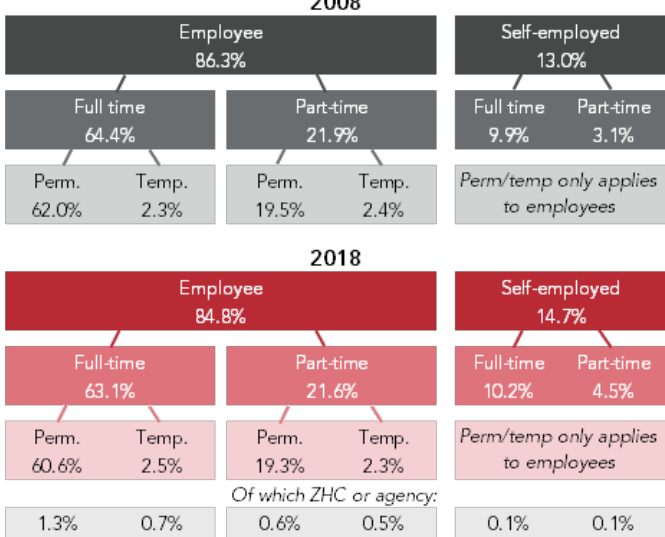
Figure 26: Full-time work for an employer remains the norm Proportion of employment, by mutually exclusive job